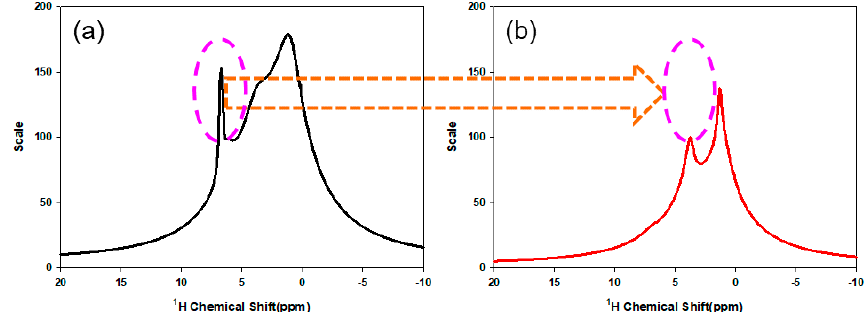
Figure 3. 1 H MAS NMR spectra of the TCR-1 sample. ( a ) Before hydrolysis, ( b ) After hydrolysis.